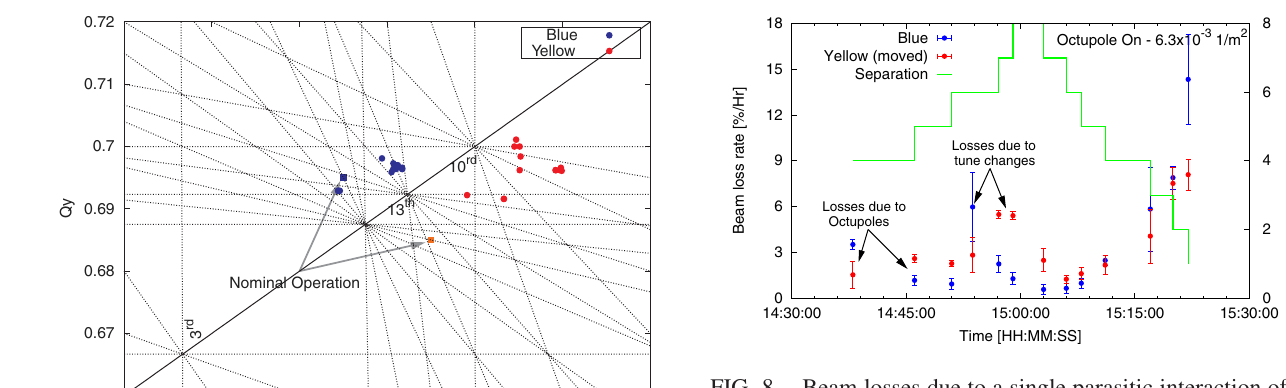
FIG. 8. Beam losses due to a single parasitic interaction of the Blue and Yellow beam. The Yellow beam moved closer to the Blue beam from an initially large separation.